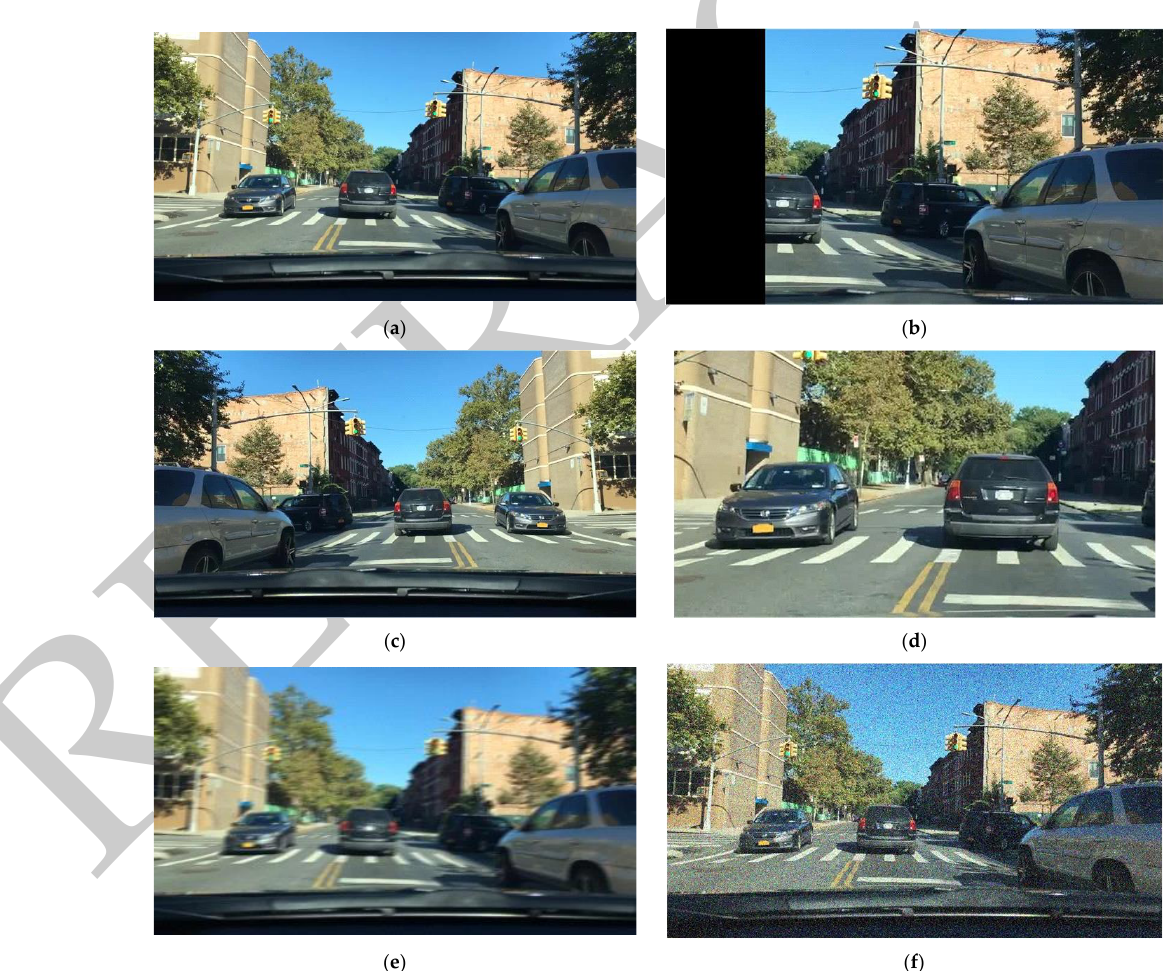
Figure 8. Data augmentation methods ( a ) original image ( b ) displacement ( c ) horizontal flipping ( d ) random cropping ( e ) motion blurring ( f ) random noise adding.